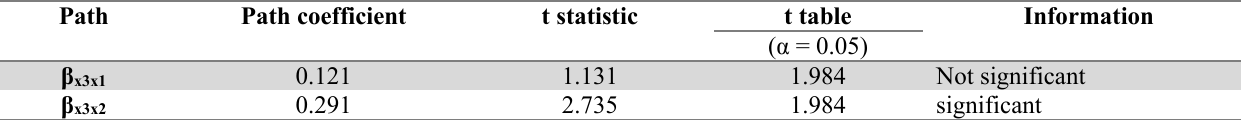
Calculation Results for the Test for the Path Coefficient Model 1 Sub-Structure-1 Path Path coefficient t statistic